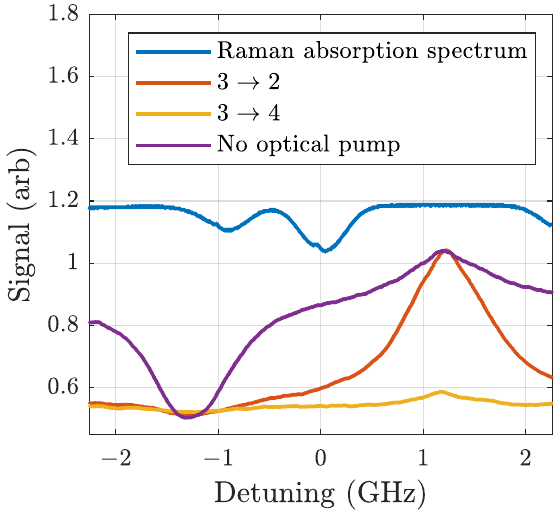
Figure 4. Measurement of the atomic beam fluorescence versus auxiliary laser frequency with no optical pumping (solid purple trace), optical pumping on the F = 3 → F (cid:48) = 4 transition (dashed yellow trace), and optical pumping on the F = 3 → F (cid:48) = 2 transition (dotted and dashed orange trace). The single-pass absorption signal from the scanning auxiliary laser (dotted blue trace) is included as a frequency reference (and here one can see the 1.5 GHz frequency shift due to our selection of the red-shifted Raman beam as the auxiliary laser). Of note, not only is F = 3 → F (cid:48) = 3 more difficult to produce with our equipment than F = 3 → F (cid:48) = 2, but it also provides less efficient optical